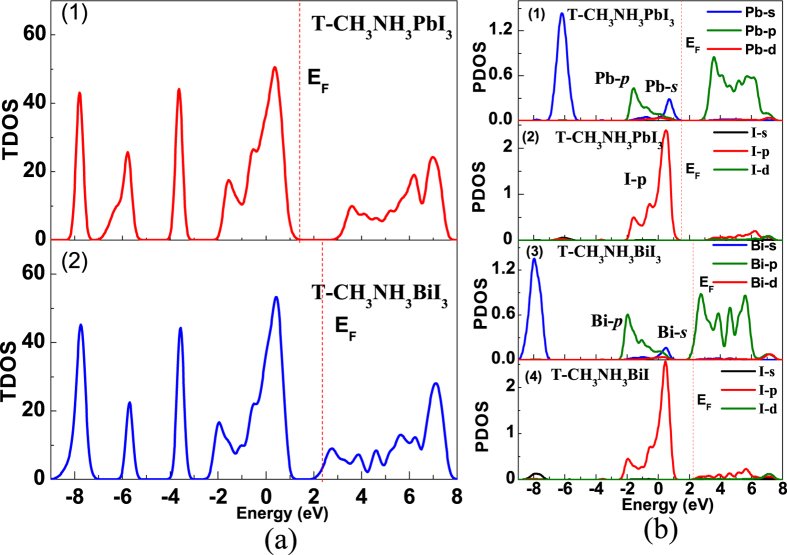
Calculated density of states of T-CH3NH3PbI3 and T-CH3NH3BiI3, (a) TDOS, (b) PDOS. The red dashed lines represent the Fermi level.